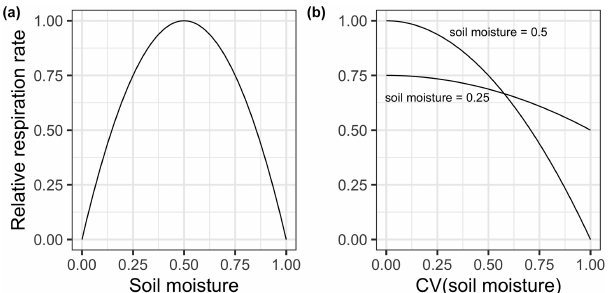
Figure 3. (a) Heterotrophic respiration as a function of soil mois- ture given the solution in Eq. (25). Note that soil moisture is nor- malized with a maximum response at 0.5, where 1 represents com- plete waterlogging, and respiration is normalized to a maximum of 1. (b) Scale transition approximate solution for respiration as a function of the dimensionless coefficient of variation in soil mois- ture where mean field soil moisture is either 0.5 (top curve) or 0.25 (bottom curve, equivalent to 0.75 by